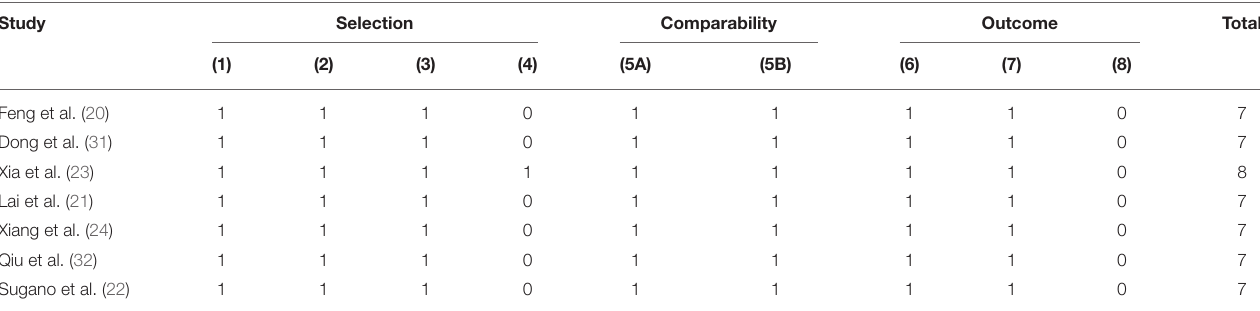
TABLE 2 | Newcastle-Ottawa Scale of included